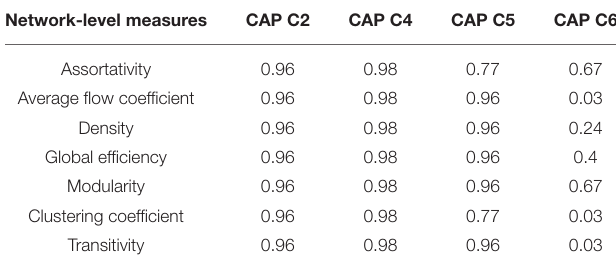
opioid use and psychological disorders on the developing infant